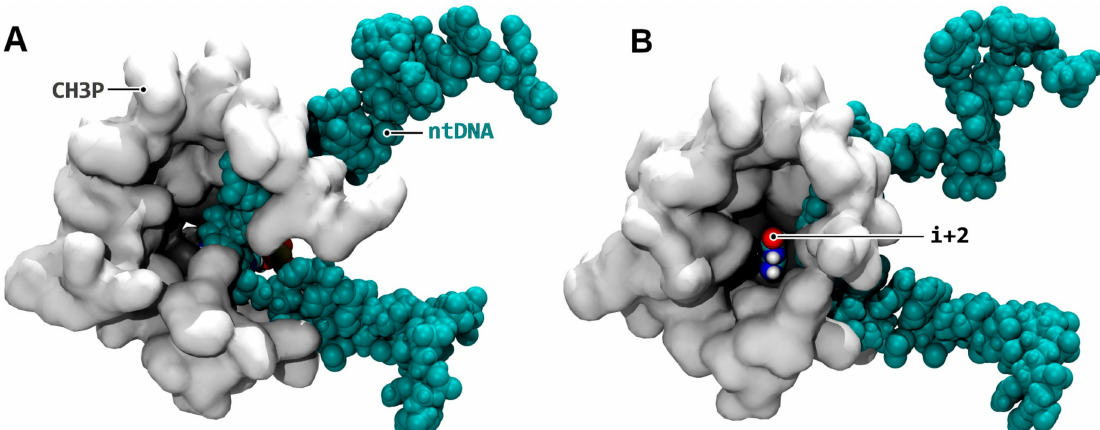
Figure 2. TFIIF-induced trapping of the i + 2 downstream register. ( A ) Configuration before (simulation aMD_A1, 15 ns); ( B ) After (aMD_A1, 220 ns) the relaxation of TFIIF. The folding of non-template DNA ( B ) frees up a cavity inside the protein represented as white surface, which in turn allows the template i + 2 register (colored by atomic type) to insert inside the cavity. The amino acids (RPB1 852, 853,